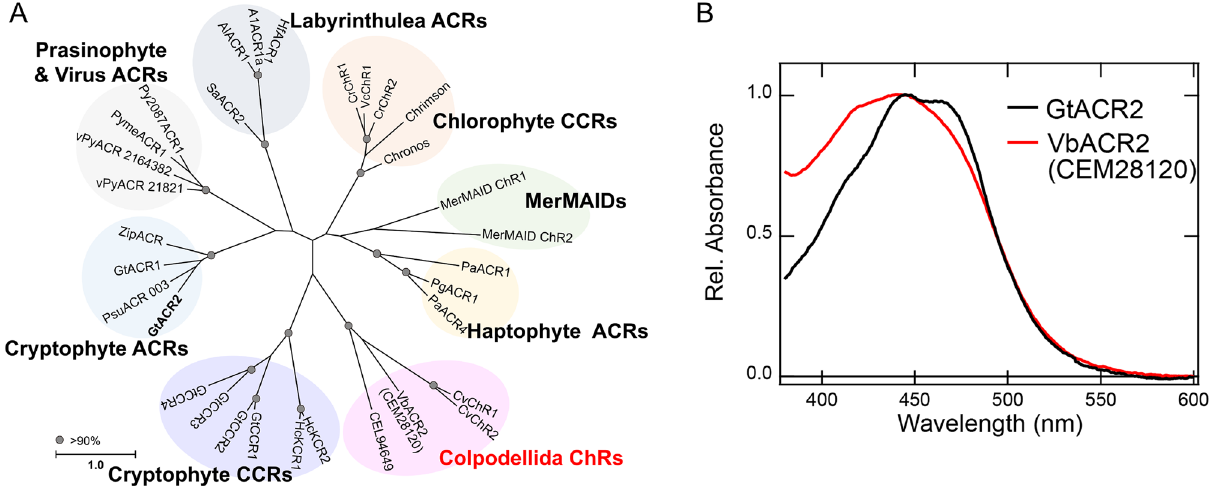
Figure 1. Phylogenetic relationship of channelrhodopsins and absorption spectra of VbACR2 and GtACR2. ( A ) The phylogenetic tree of known channelrhodopsins and Colpodellida ChRs [CEL94649 and VbACR2 (CEM28120)] with gray circles representing bootstrap values > 90%. The scale bar represents the average number of amino acid substitutions per site. The phylogenetic tree was inferred using the maximum likelihood method of MEGA X software (version 10.2.2) 57 . Accession numbers of the sequence data in the tree are as follows: CrChR1, AAL08946; CrChR2, AAM15777; VcChR1, AAZ66339; Chronos, AHH02106; Chrimson, AHH02126; GtCCR1, ANC73520; GtCCR2, ANC73518; GtCCR3, ANC73519; GtCCR4, ARQ20888; HcKCR1, MZ826861; HcKCR2, MZ826862; GtACR1, KP171708; GtACR2, KP171709; ZipACR, APZ76709; PsuACR_003, APZ76711; PymeACR1, MT353682; Py2087ACR1, QNU12852; vPyACR_21821, QNU12854; vPyACR_2164382, QNU12855; MerMAID ChR1, QCW06519; MerMAID ChR2, QCW06520; PgACR1, MT002472; PaACR1, MT002471; PaACR4, MT002464; AlACR1, MT002467; A1ACR1a, MT002468; HfACR1, MT002469; and SaACR2, MT002463. ( B ) The absorption spectra of the purified VbACR2 (CEM28120) in SMA lipid particles and GtACR2 in DDM micelles. The spectra were normalized at peak